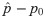
Simulated bottleneck with constant sex-bias.Bottleneck simulations with a constant proportion of females, p0. (A) Autosomal demographic model with time on the x-axis and effective population size on the y-axis. (B) Test statistics for the test for constant sex-bias, Λ0, with the parametric bootstrap critical value in gray. (C) Bias of estimators of the proportion of females, p^−p0, is shown for our estimator, p˜, and the estimator based on pairwise sequence diversity, pπ. Our estimator is unbiased while the pπ is increasingly biased for small p0 and at times negative.